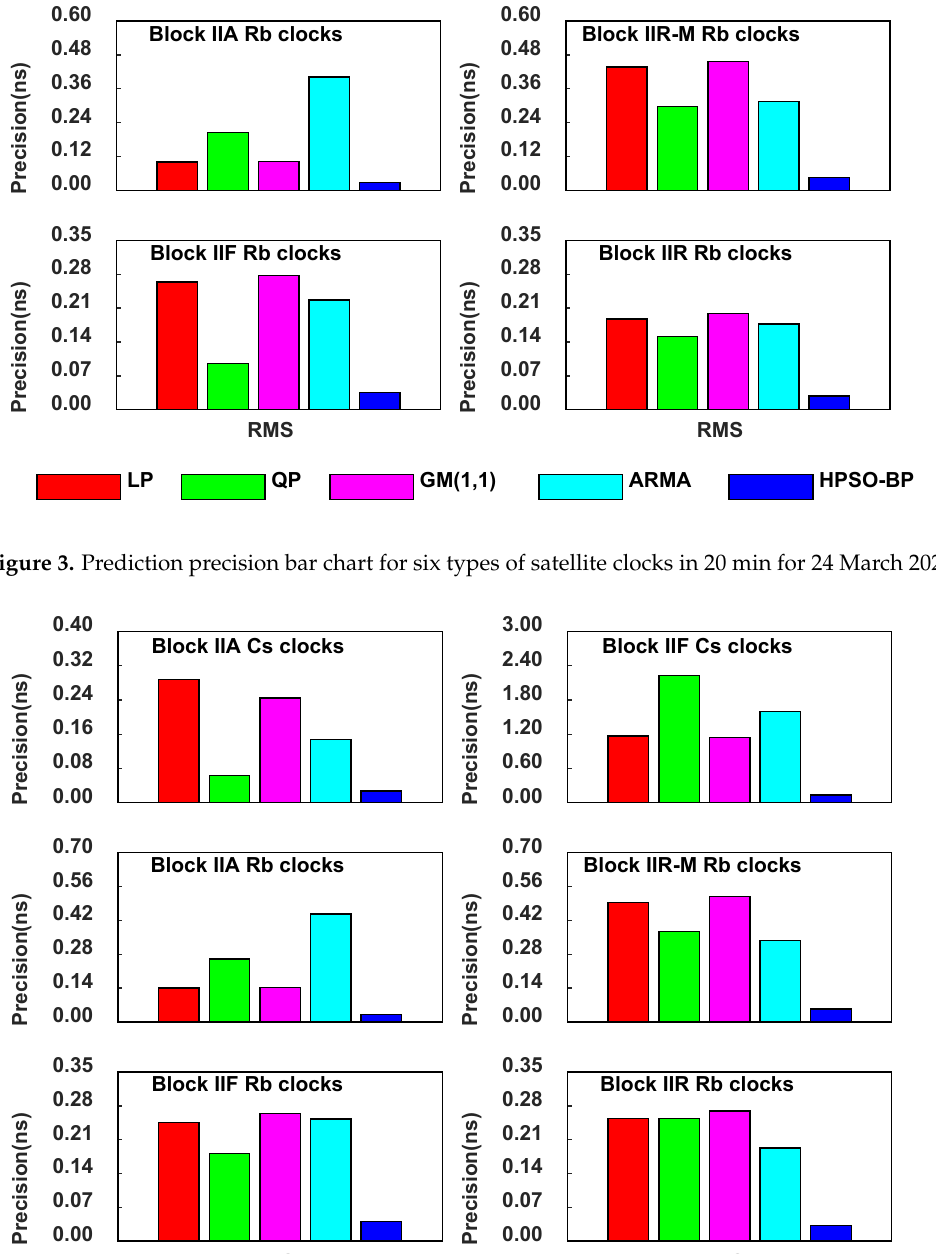
Figure 4. Prediction precision bar chart for six types of satellite clocks in 60 min for 24 March 2021. Table 6. Statistics of average prediction results of five models for six different clock types (20-min forecasting) (Unit: ns, LP, QP, GM (1,1) and ARMA represent the linear polynomial model, the quadratic polynomial model, the gray system model and the auto regression moving average model, respectively).